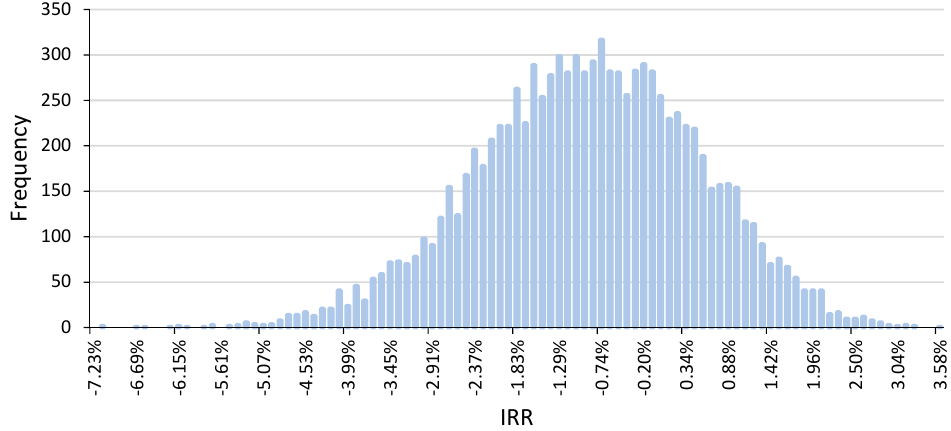
Figure 8. Histogram of the internal rate of return (IRR) calculated with the Monte Carlo method for a 5 kW system.